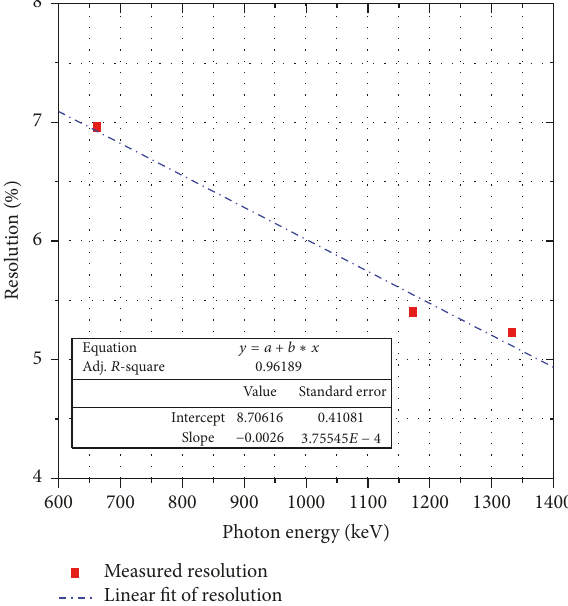
Figure 5: The calibration energy curves (measured and fit) using standard point sources ( 60 Co and 137 Cs) with NaI(Tl) well-type detector.